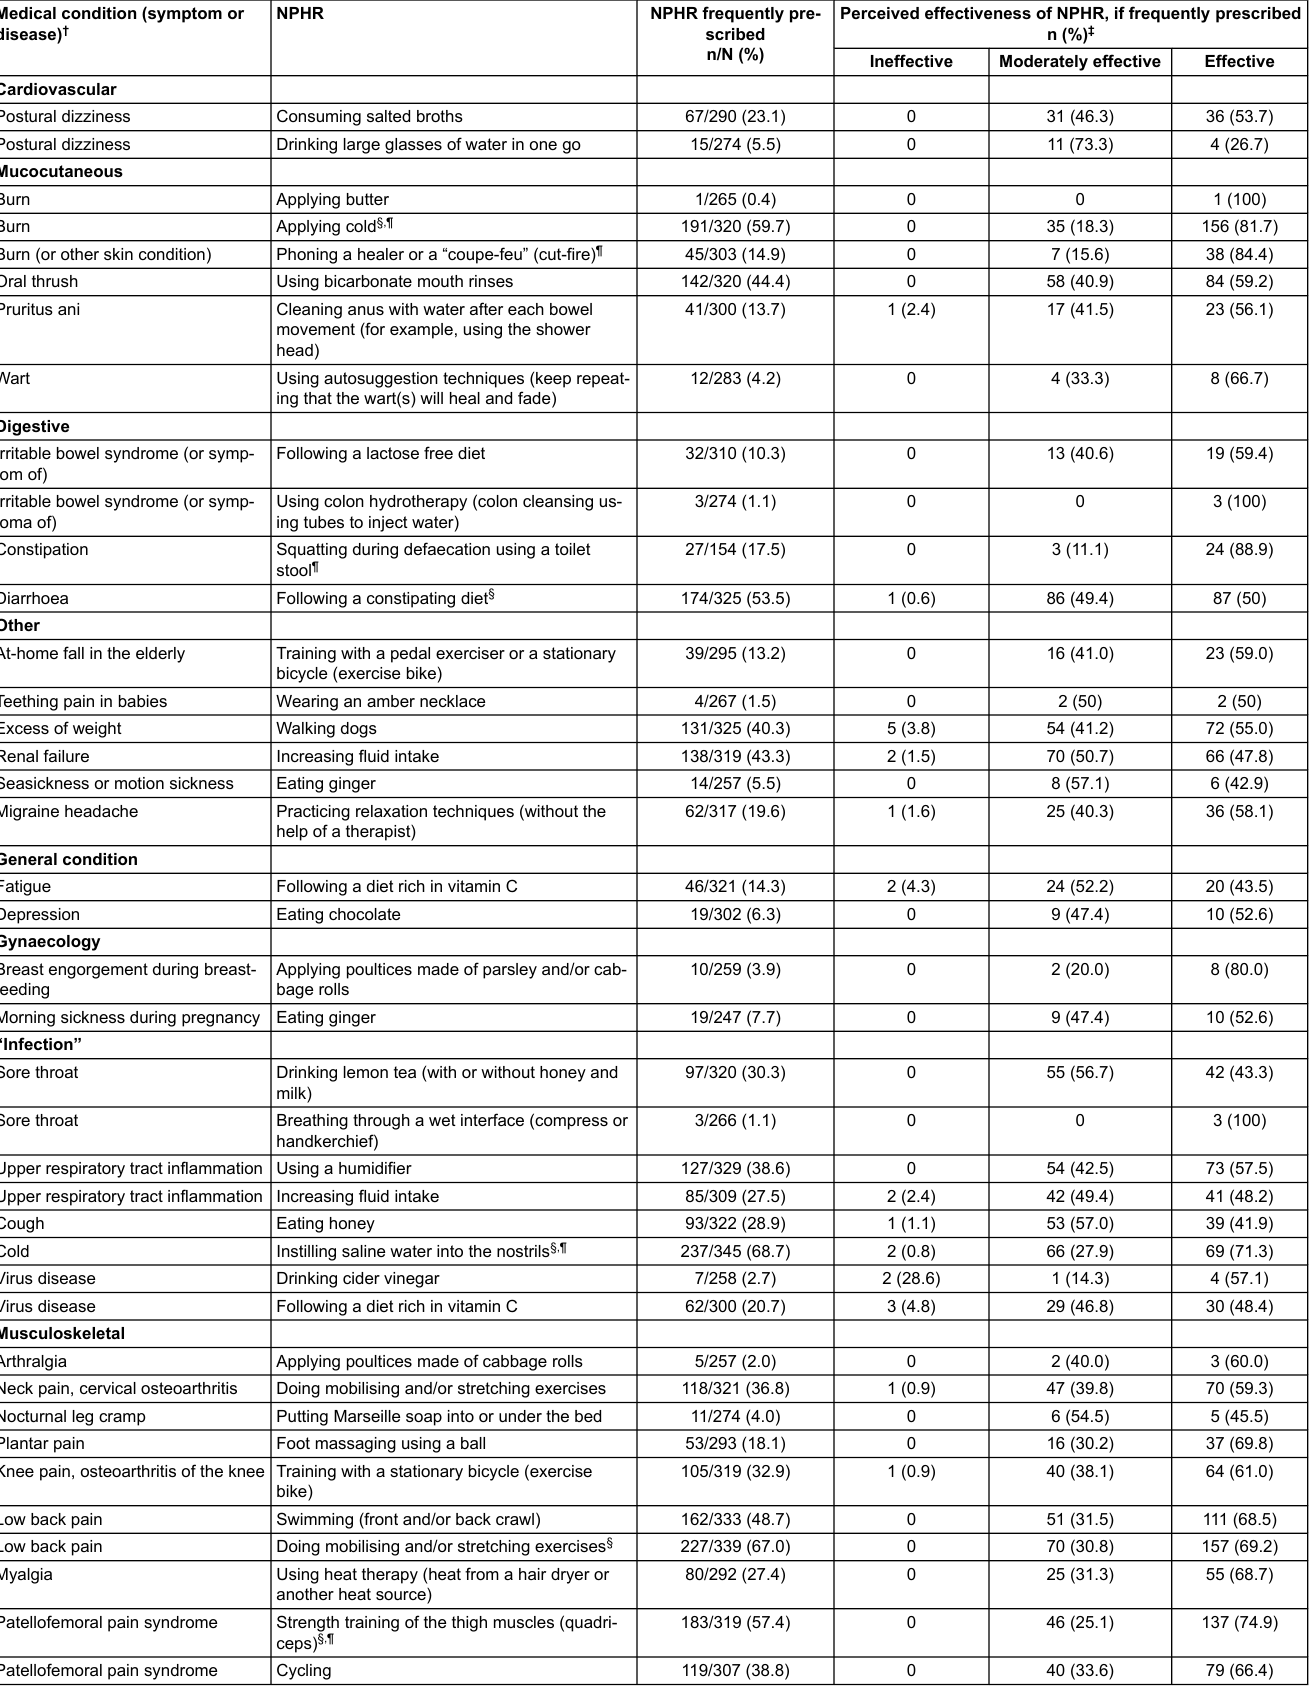
Table 2: Frequently prescribed nonpharmacological home remedies (NPHRs) * and perceived effectiveness if frequently prescribed, as well as the top five most frequently pre- scribed and the top five most effective NPHRs. Medical condition (symptom or disease)